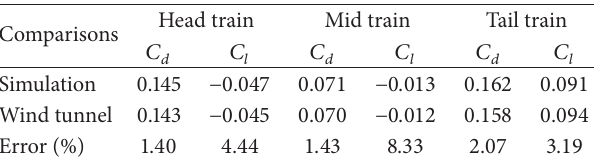
Figure 6: The 1 :8 scale train model in the aerodynamic force wind tunnel. Table 4: Comparison of the time-averaged force coefficients bet- ween simulation and